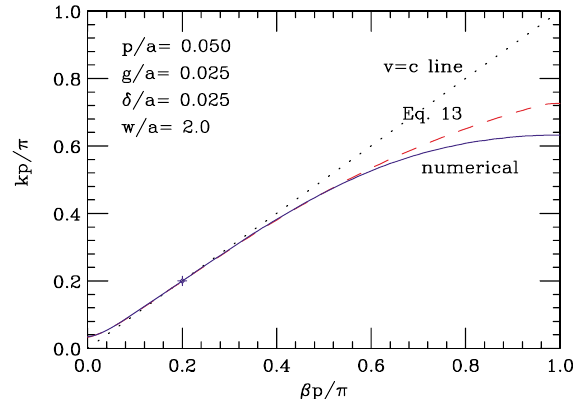
FIG. 4. (Color) A dispersion curve example: shown are the numerical result (solid line), the synchronous point (the cross plotting symbol), and the approximation, Eq. (13) (dashed line). Also shown is the speed of light line (dotted